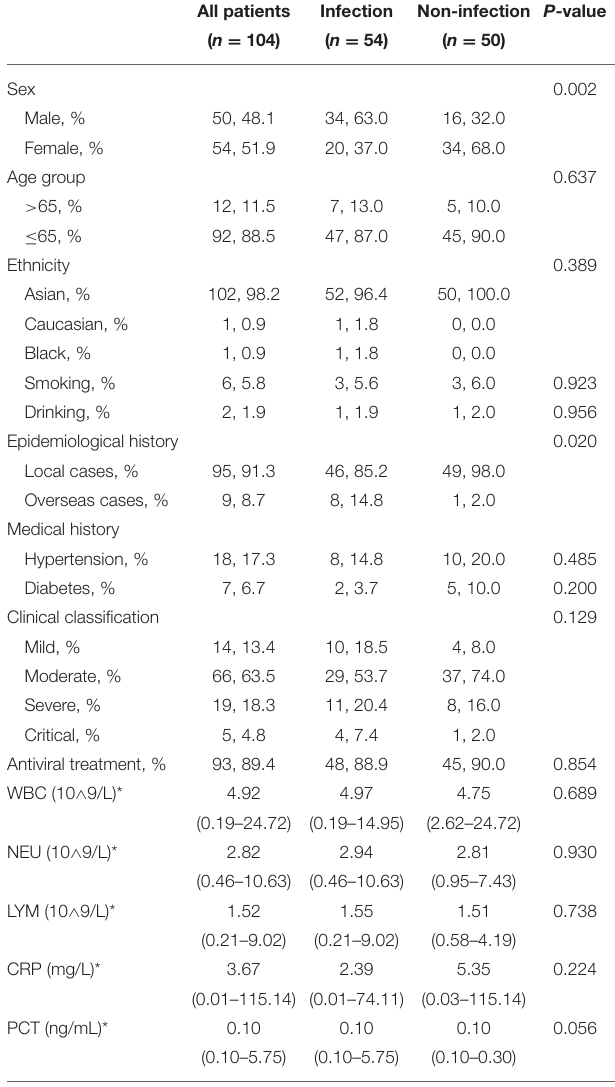
We monitored CT value of fecal sample from 16 patients during their hospitalization. As shown in Figure 3 , CT values of the fecal sample ranged from 11 to 40. The mean of the initial and the final CT values is 23.59 and 36.22, respectively (difference in for Patient 11, 13, and 16, the CT values of the other 13 patients increased slowly over time during their hospitalization. The CT values of Patient 1 and 6 increased < 1 over 25 and 29 days. Among 3 patients (Patient 5, Patient 11, and Patient 15) undergoing upper GI endoscopy, SARS-CoV-2 nucleocapsid was detected in the cytoplasm of gastric glandular epithelial cells in 2 patients (Patient 11 and 15), who remained positive for fecal SARS-CoV-2 RNA after negative conversion of viral RNA from pharyngeal swabs ( Table 2